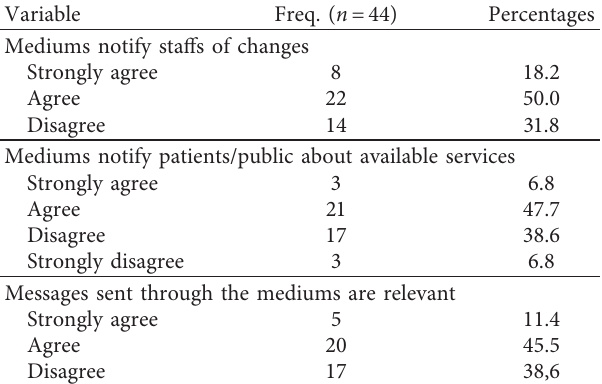
Table 3: Communication mediums as examined by management.